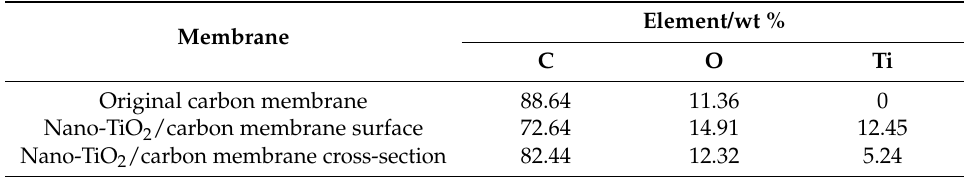
Nano-TiO 2 /carbon membrane cross-section